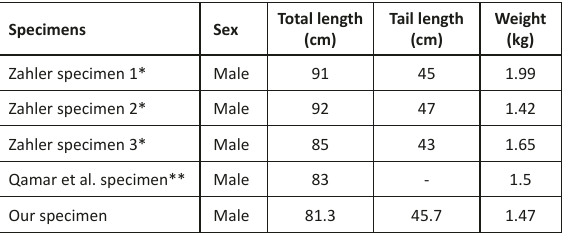
Table 1. Comparison of the Woolly Gliding Squirrel reported in this paper with earlier specimens